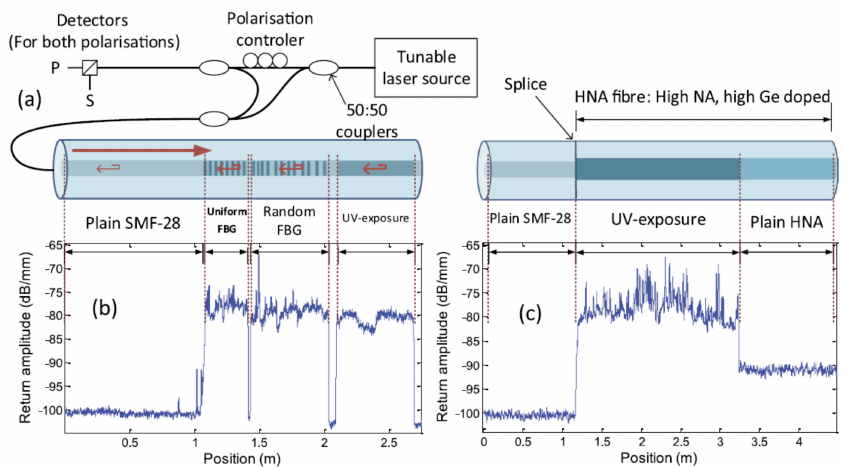
Figure 34. ( a ) OFDR system. ( b ) A comparison of various types of structure and exposure in a standard SMF-28 fiber: uniform FBG, random FBG and continuous UV exposure (no FBG). ( c ) A comparison of SMF-28, with UV-exposed and un-exposed HNA fiber (HNA: High NA fiber with high Ge core) (reprinted from Loranger et al. [40] with permission of Springer Nature; copyright